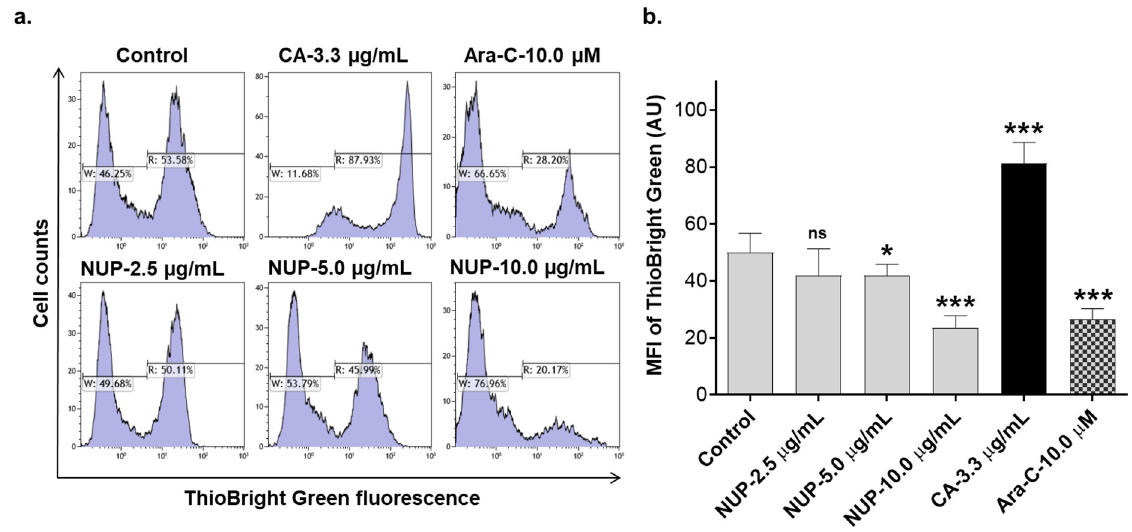
Figure 5. NUP induces a decrease in cellular GSH levels after a longer treatment. Following treatment with vehicle or indicated concentrations of NUP, for 24 h, HL60 cells were loaded with ThioBright Green followed by flow cytometric analysis, as described in Materials and Methods. ( a ) Typical examples of cellular GSH measurement from a representative experiment. ( b ) Averaged GSH levels expressed as ThioBright Green geometric mean fluorescence intensity (MFI) units. The data are means ± SD of 3 independent experiments performed in duplicate. *, p < 0.1 and ***, p < 0.001 vs. vehicle-treated (control) cells; ns, non-significant. CA, carnosic acid; AraC, 1- β -D-arabinosylcytosine.